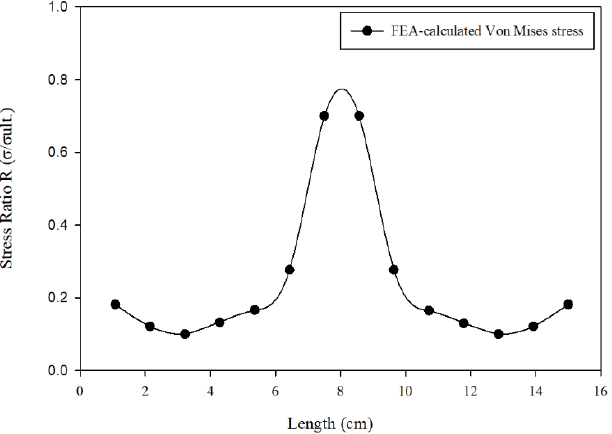
Figure 5. The centerline stress ratio profile that was used in the specimen design.